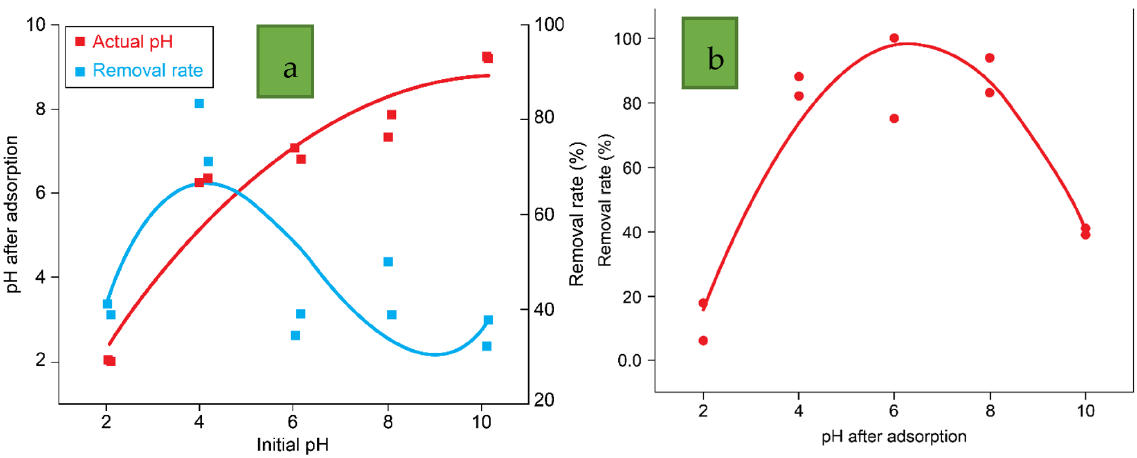
Figure 5. Effect of pH on the matrix of agar – La when the initial concentration of PO 43 − was 10 mg/L ( a ); effect of pH on adsorption by agar – La after 40 h ( b ). ( a ); effect of pH on adsorption by agar–La after 40 h ( b